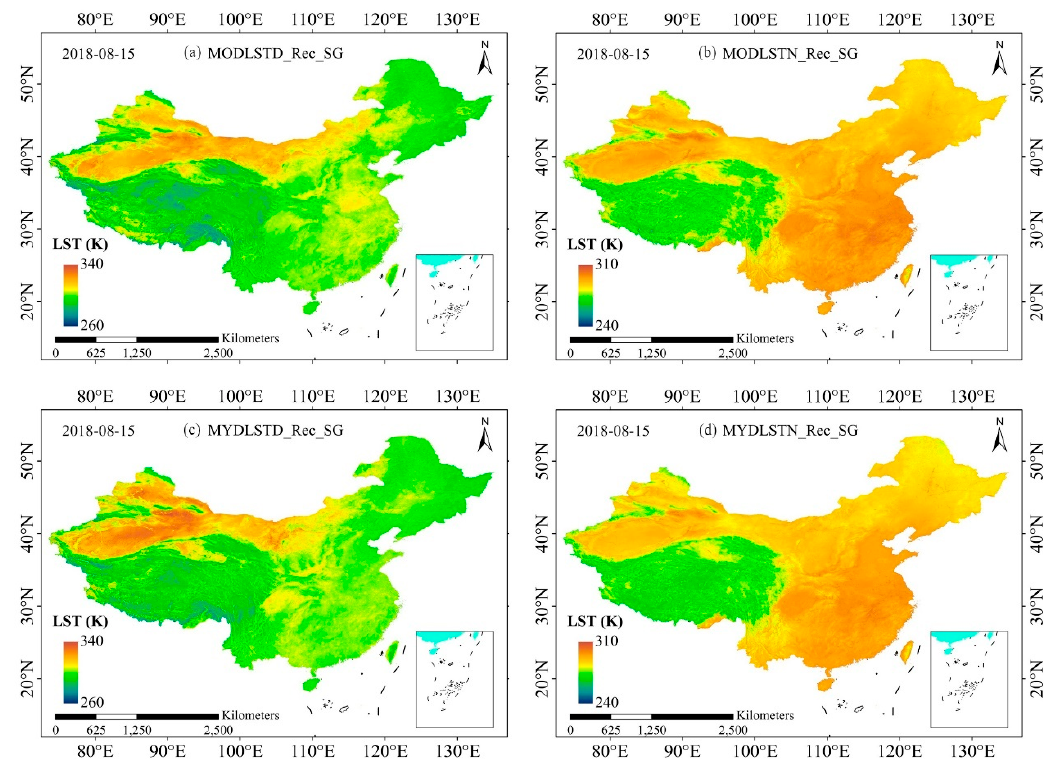
Figure A3. Reconstructed MODIS LST results on 15 August 2018.